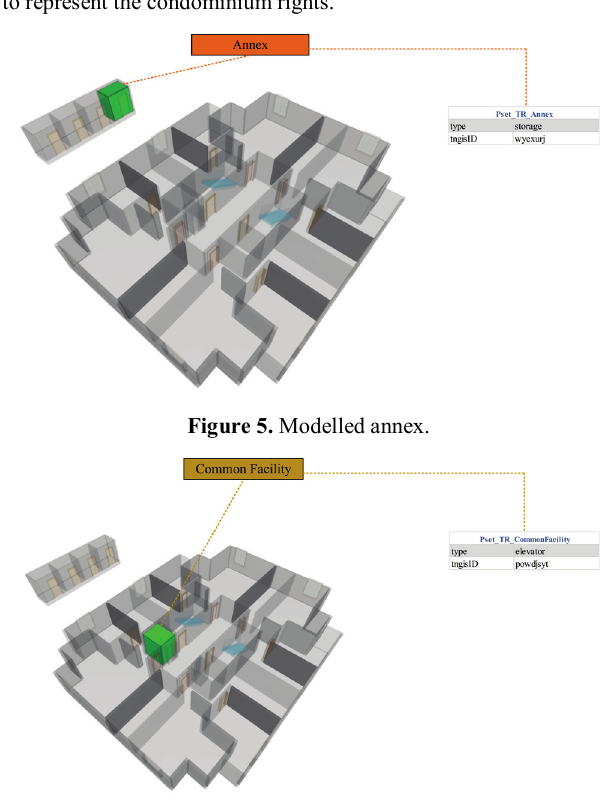
Figure 6. Modelled elevator as a common